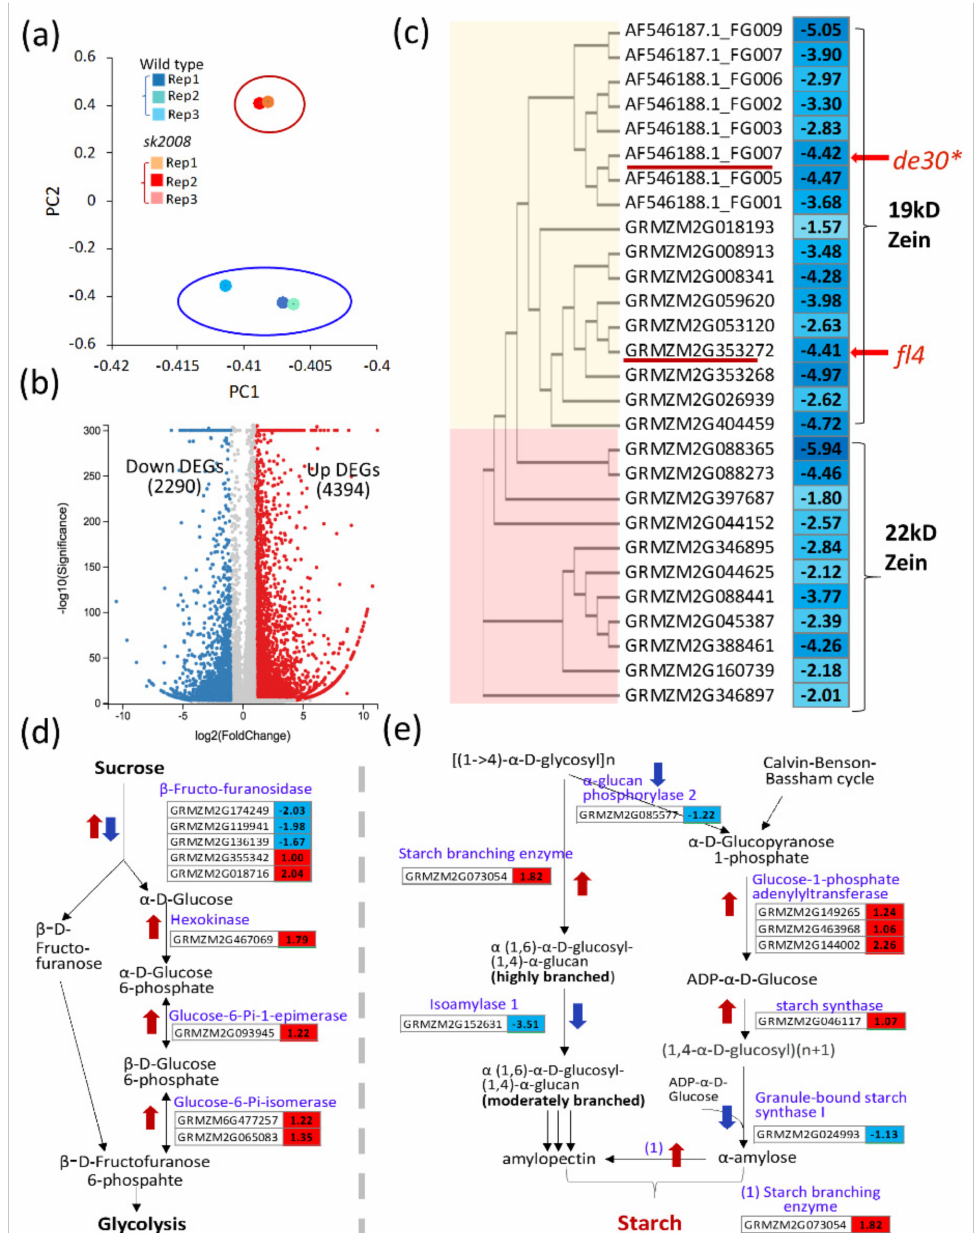
Figure 6. Gene expression changes in the sh2008 compared with WT. ( a ) Principal component analysis (PCA) of data from the RNAseq analysis for the 15 DAP kernels collected from the sh2008 mutant and WT lines can be distinguished into two groups. ( b ) Volcano plots indicate the number of DEGs that were downregulated or upregulated in comparing sh2008 mutant to WT. DEGs were identified with Q < 0.05 and absolute log2-fold value ( sh2008 /WT) >1. ( c ) The downregulated DEGs encoding 19 kDa and 22 kDa zein proteins in comparing sh2008 mutant to WT ( sh2008 /WT). Zein protein-coding genes were grouped into two groups based on the amino acid alignment result by using ClustalW2 (https://www.ebi. ac.uk/Tools/msa/clustalo/, accessed on 8 November 2021). The predicted translated protein sequences were based on the maize B73 genome sequence and annotation from maizeGDB (https://www.maizegdb.org, accessed on 8 November 2021) or/and EnsemblPlants (http://plants.ensembl.org/index.html, accessed on 8 November 2021). ( d , e ) DEGs in sucrose degradation ( d ) and starch synthesis ( e ) comparing sh2008 and WT. Schematic of the pathways modified according to the KEGG (https://www.kegg.jp/kegg/pathway.html, accessed on 8 November 2021) and metabolic pathways at MaizeGDB (https://www.maizegdb.org/metabolic_pathways (accessed on 8 November 2021)). The color of the box represents up (red) and down (green)-regulated genes ( sh2008 /WT), and the value in the box is the log2 ( sh2008 /WT) of the genes in comparing the sh2008 mutant to